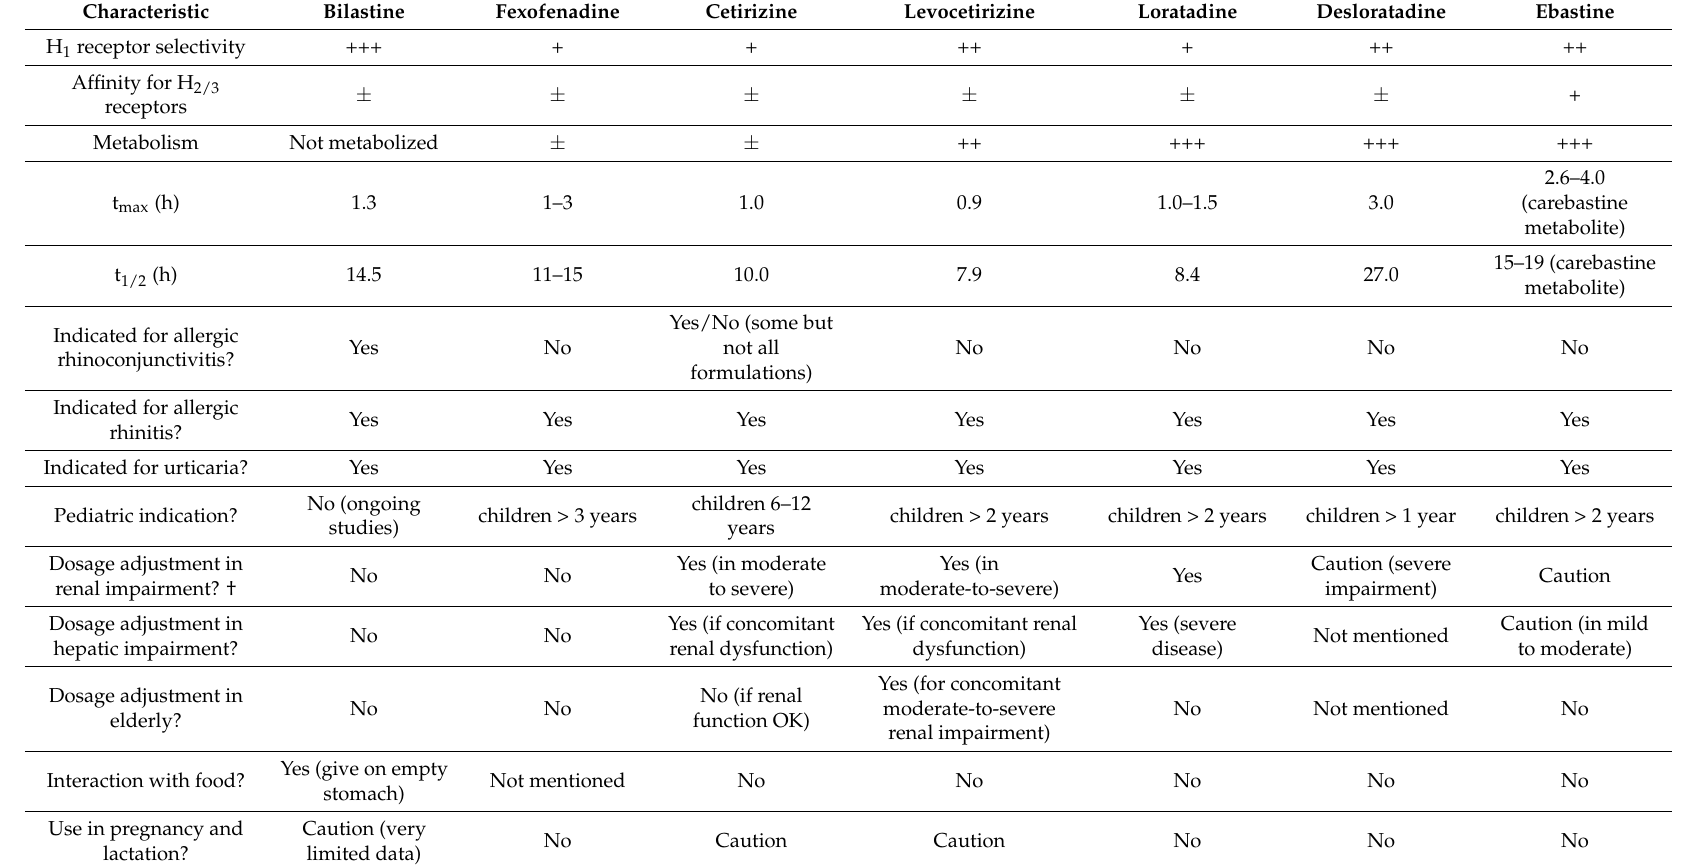
Table 1. Clinical profiles of representative second-generation H 1 antihistamines